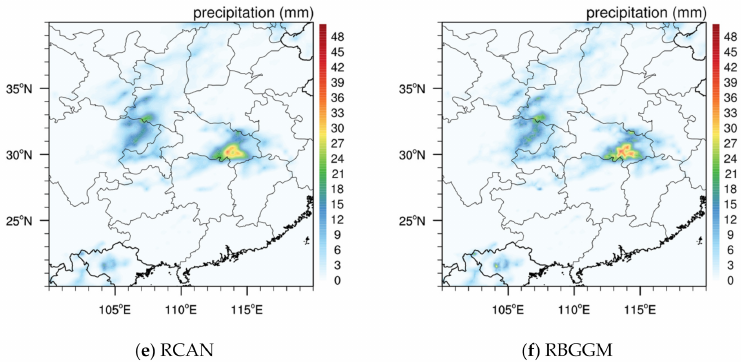
Figure 12. Distribution of GPM precipitation: ( a ) original GPM precipitation; and ( b ) GPM 0.4 ◦ ; as well as precipitation downscaling results: ( c ) bi-linear; ( d ) SRCNN; ( e ) RCAN; and ( f ) RBGGM.